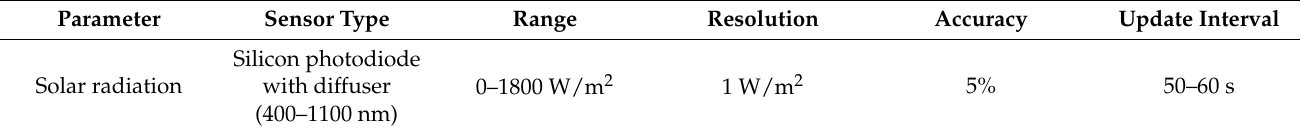
Table 3. Technical characteristics of the weather station used in NOAAN